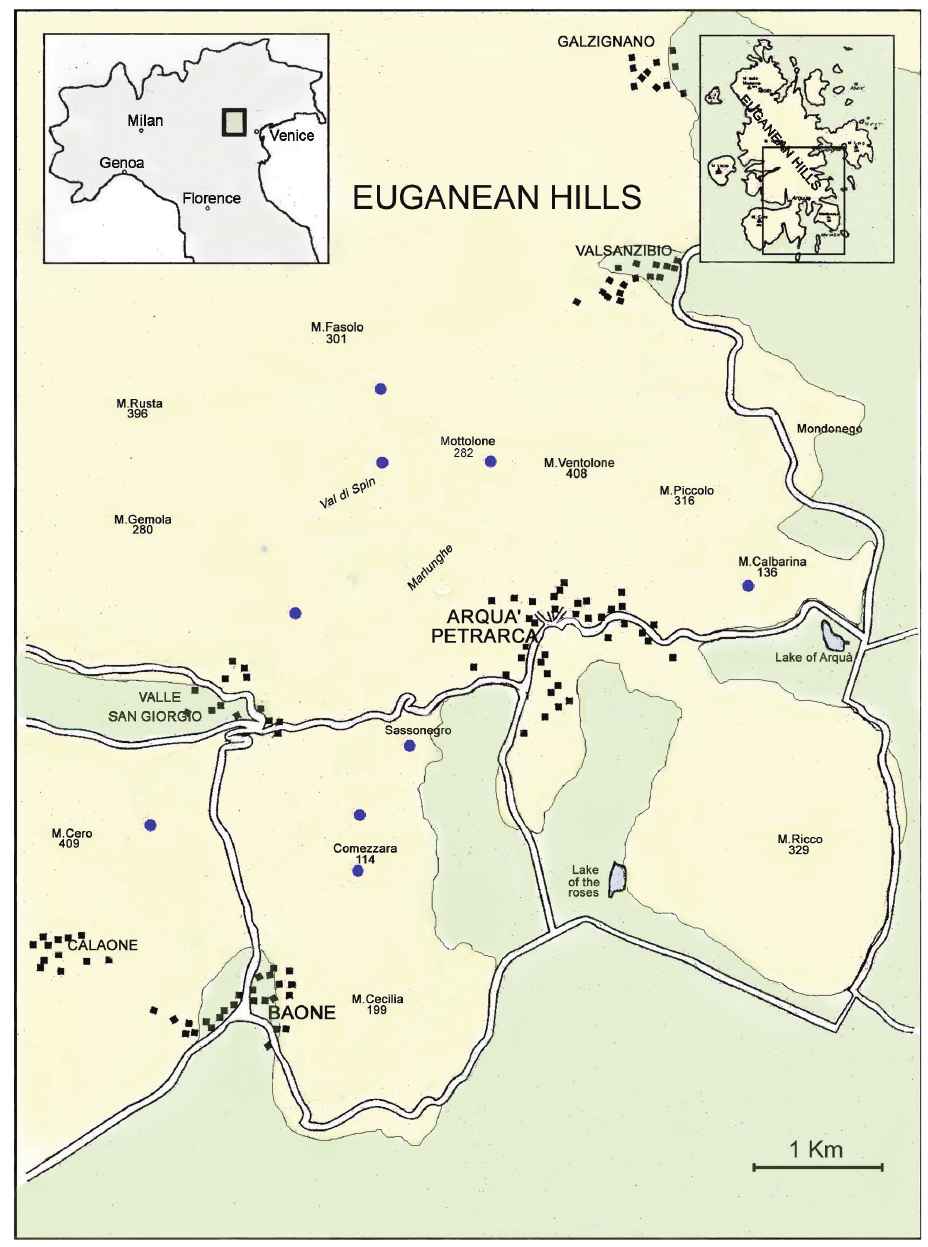
Figure 3. Distribution (blue dots) of Haplophyllum patavinum (L.) G.Don in the Euganean Hills (Pad- ua) as resulting from the surveys carried out in the years